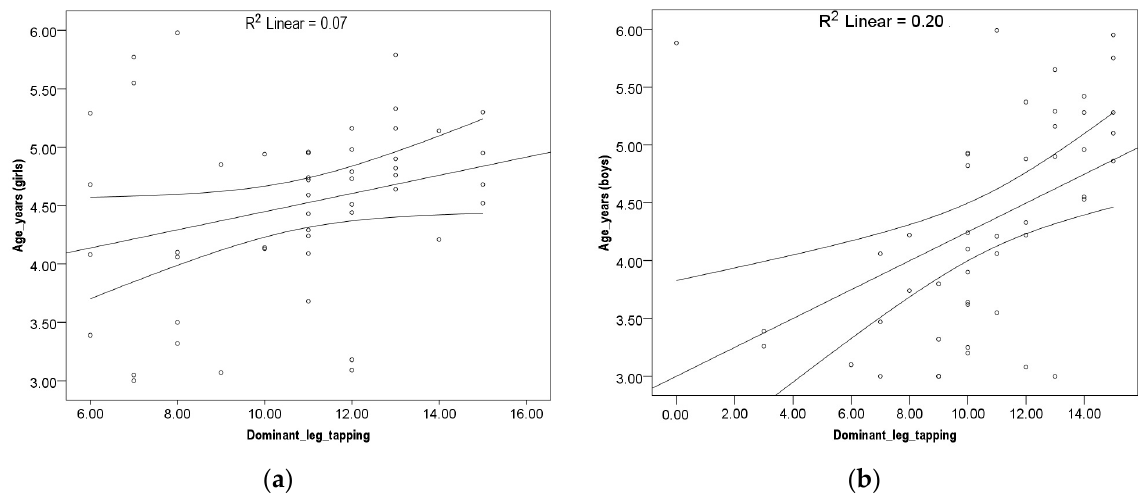
Figure 2. ( a ) Legs tapping girls. ( b ) Legs tapping boys.